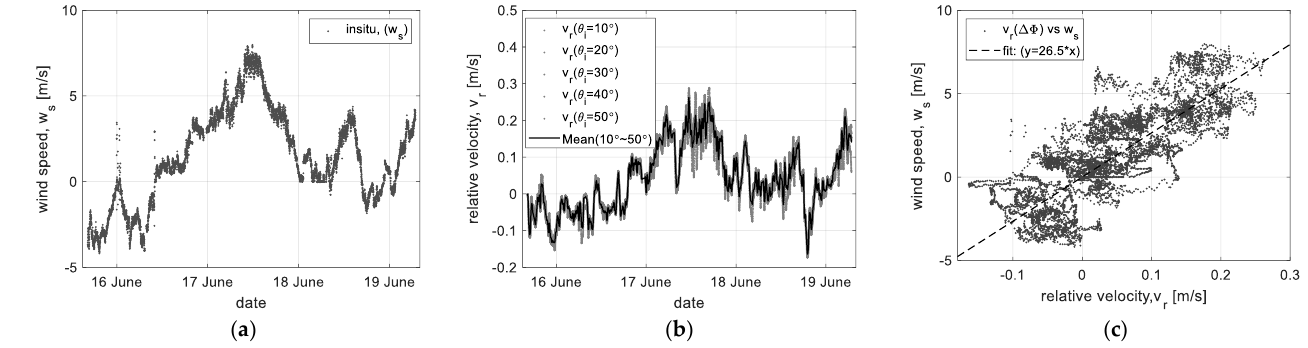
Figure 8. Correlation analysis of the relative velocity ( v r ) versus wind speed ( w s ): ( a ) the in situ data ( w s ), ( b ) the relative velocity ( v r ), and ( c ) the result of correlation analysis.